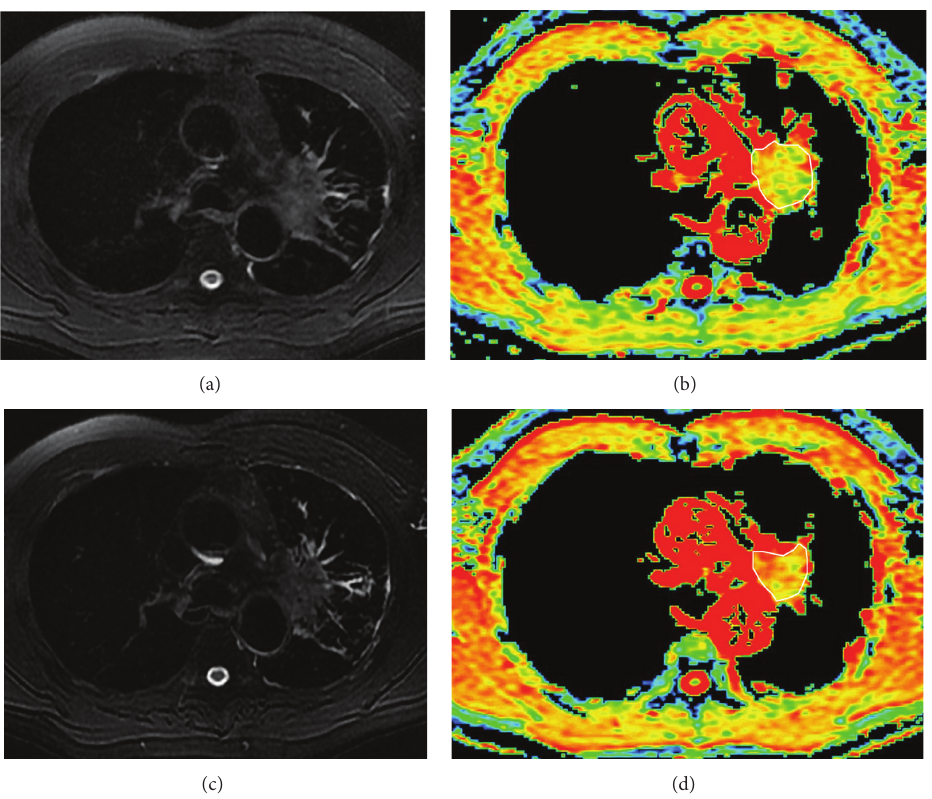
Figure 2: Graphs in 54-year-old man with squamous cell carcinoma lung cancer belong to partial response group. (a, c) T2-weighted with fat suppression images and apparent diffusion coefficient (ADC) maps (b, d) obtained before (a, b) and after the first cycle (c, d) of chemotherapy. From the T2-weighted with fat suppression images, no significant decrease in tumor size was detected (a, c) after the first cycle of chemotherapy, while the ADC value increased from 1.36 × 10 −3 mm 2 /s to 2.16 × 10 −3 mm 2 /s (b,